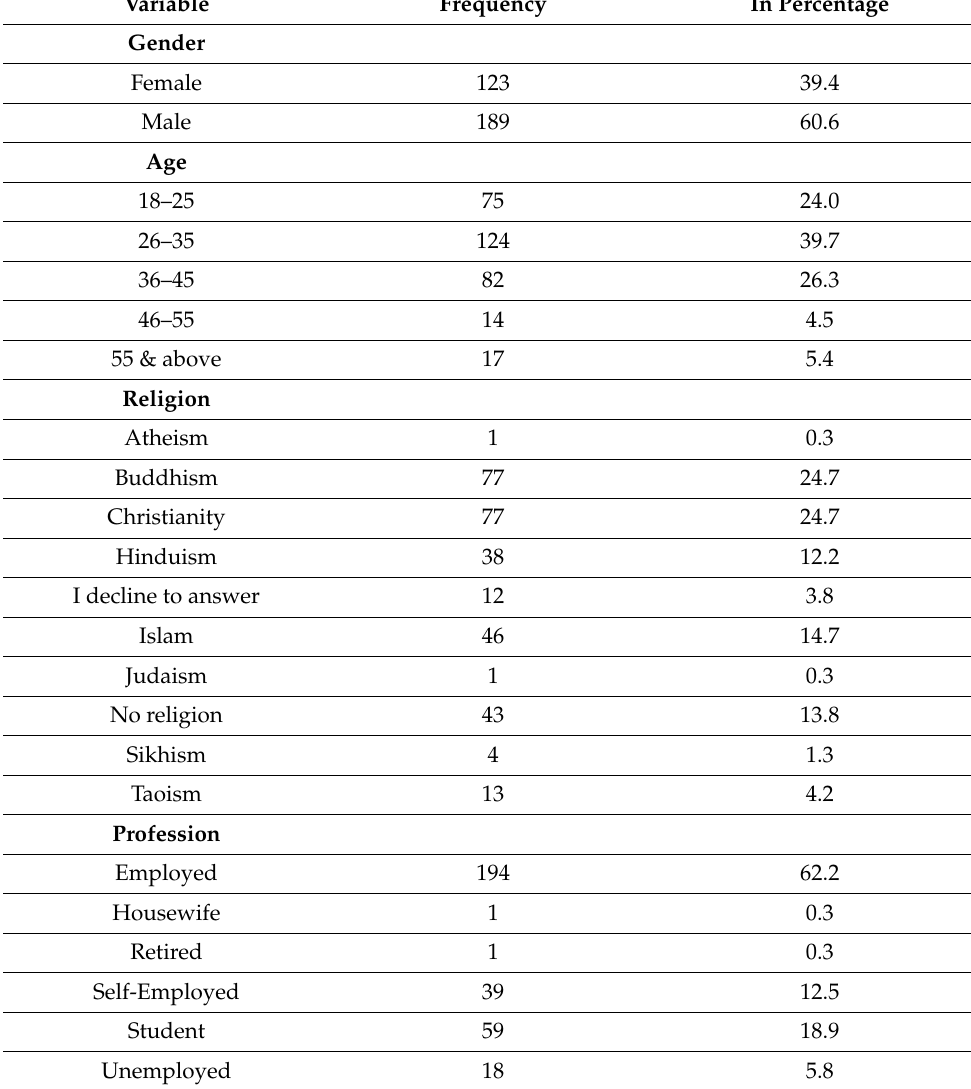
Table 3. Demographics of participants ( n =